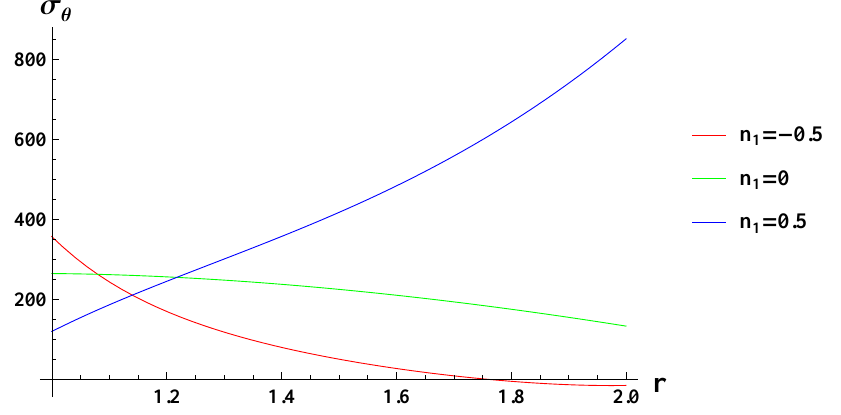
Figure 8. Tangential stress (in MPa) along the radius r (in cm) of the cylinder, under the effect of rotation ( ω 2 = 50 rad/s), external pressure p o = 50 MPa and exponential volume reinforcement. Radial strain rate under decreasing reinforcement profile n 1 = 0.5 as observed from Figure 9, is compressive and it increases exponentially towards outer radial points. Radial strain rate under increasing reinforcement profile case n 1 = − 0.5, is higher in magnitude at inner radial points but decreases towards the outer radius, whereas the exact opposite behavior is observed for the n 1 = 0 case.